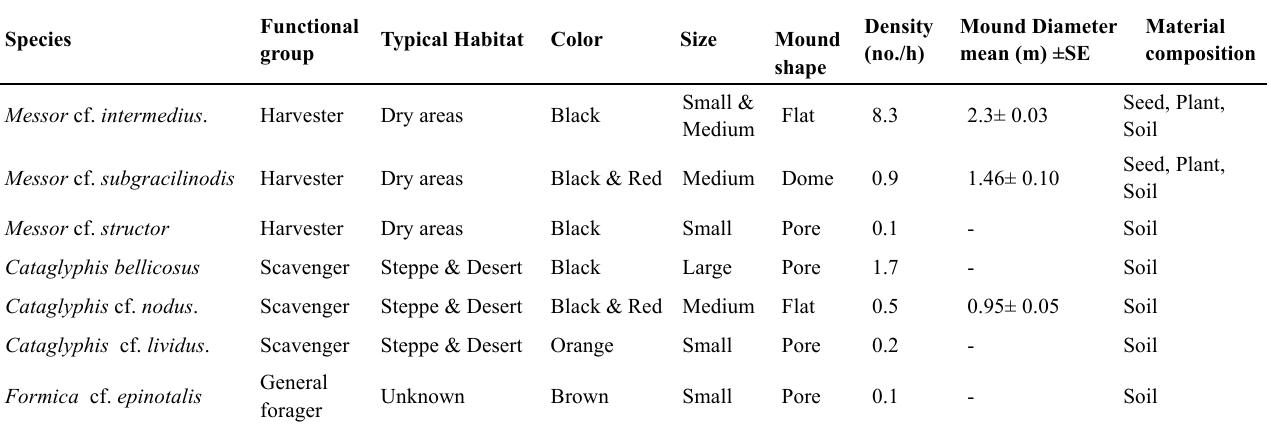
Table 1 . Properties of ant species found in the study